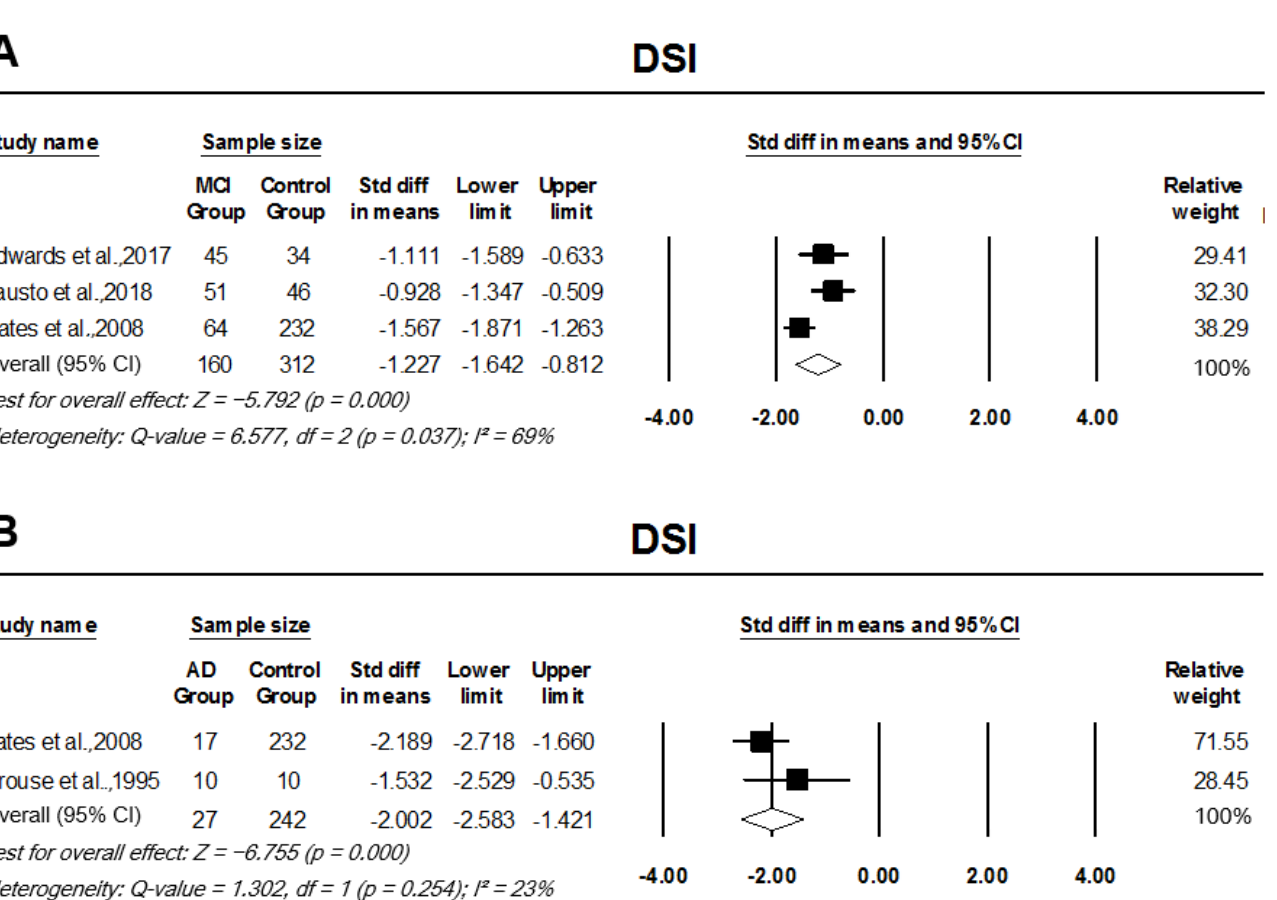
Figure 5. Forest plot of standard mean difference and overall (pooled) estimate of studies investi- gating dichotic sentence identification (DSI) test. ( A ) Analysis of DSI between the mild cognitive impairment (MCI) group and the control group; ( B ) analysis of DSI between the Alzheimer’s disease (AD) group and the control group. Notes: Z = Z score; I ² = percentage of heterogeneity; Q-value = Cochrane’s Q; df = degrees of freedom. The horizontal lines represent the 95% confidence interval (CI) for each computed standard mean difference. Weights are from the random-effects analysis.